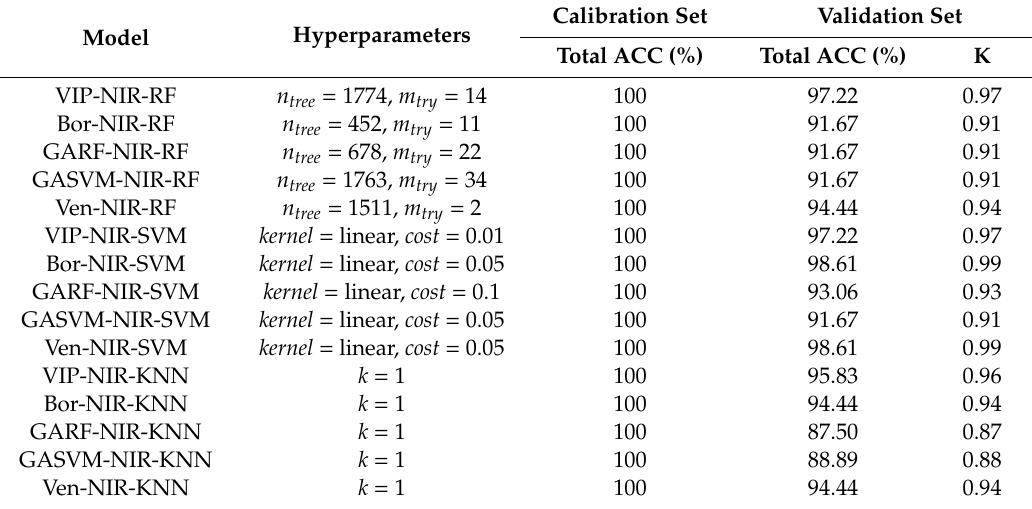
Table 7. The major parameters (accuracy and kappa) of classification models based on di ff erent NIR feature variables.